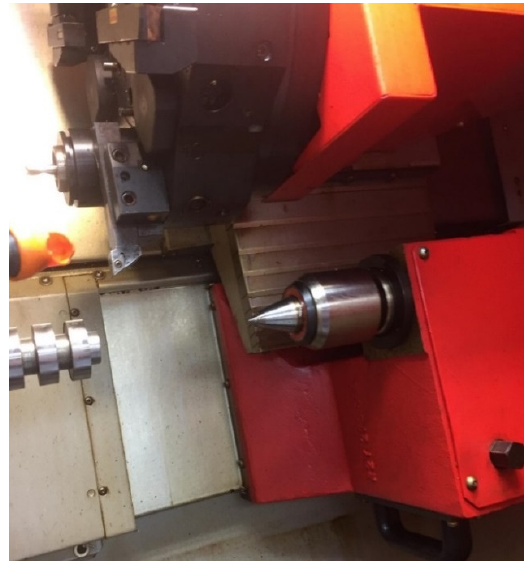
Figure 3. Experimental test rig: an EMCO Concept Turn 45 CNC lathe and clamped workpiece with cutting insert for turning test.